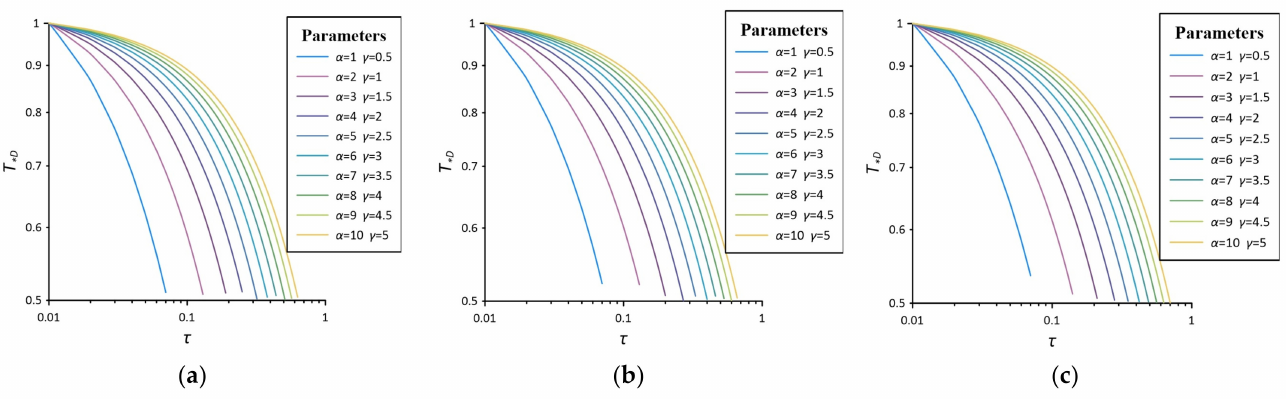
Figure 3. T ∗ D ∼ τ double logarithmic standard curves for different α , γ , β parameters in the case of u (cid:54) = 0. ( a ) β = 0; ( b ) β = − 0.5; ( c ) β = −